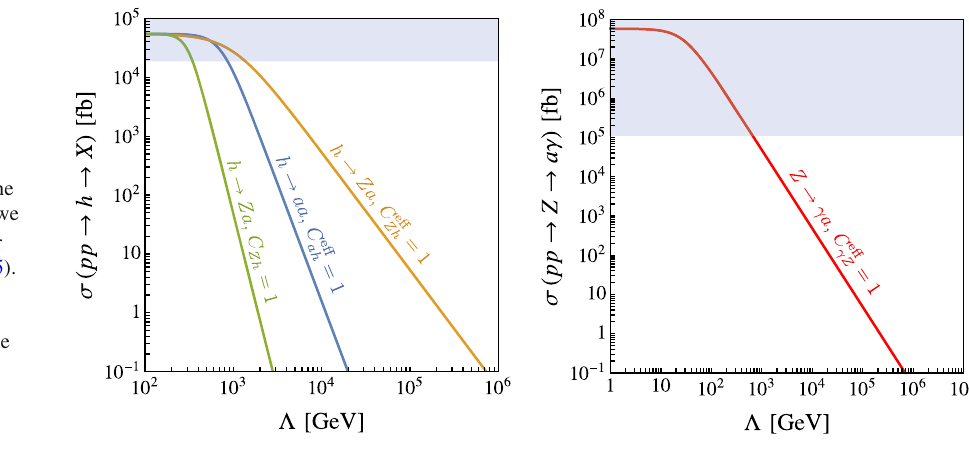
and g V = 2 s 2 w − 1 / 2 and g A = − 1 / 2. Note that the cross sections with a gauge boson in the final state become inde- pendent of s in the high-energy limit m 2 while the cross section for e + e − → ha decreases as 1 / s in this